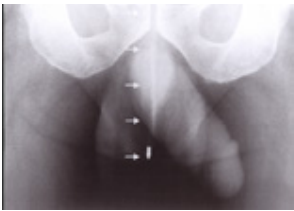
FIGURE 1. Abdominal-pelvic radiograph with the foreign body spanning the bulbar urethra, prostatic urethra, and the bladder neck. Arrows denote the location of the pen.